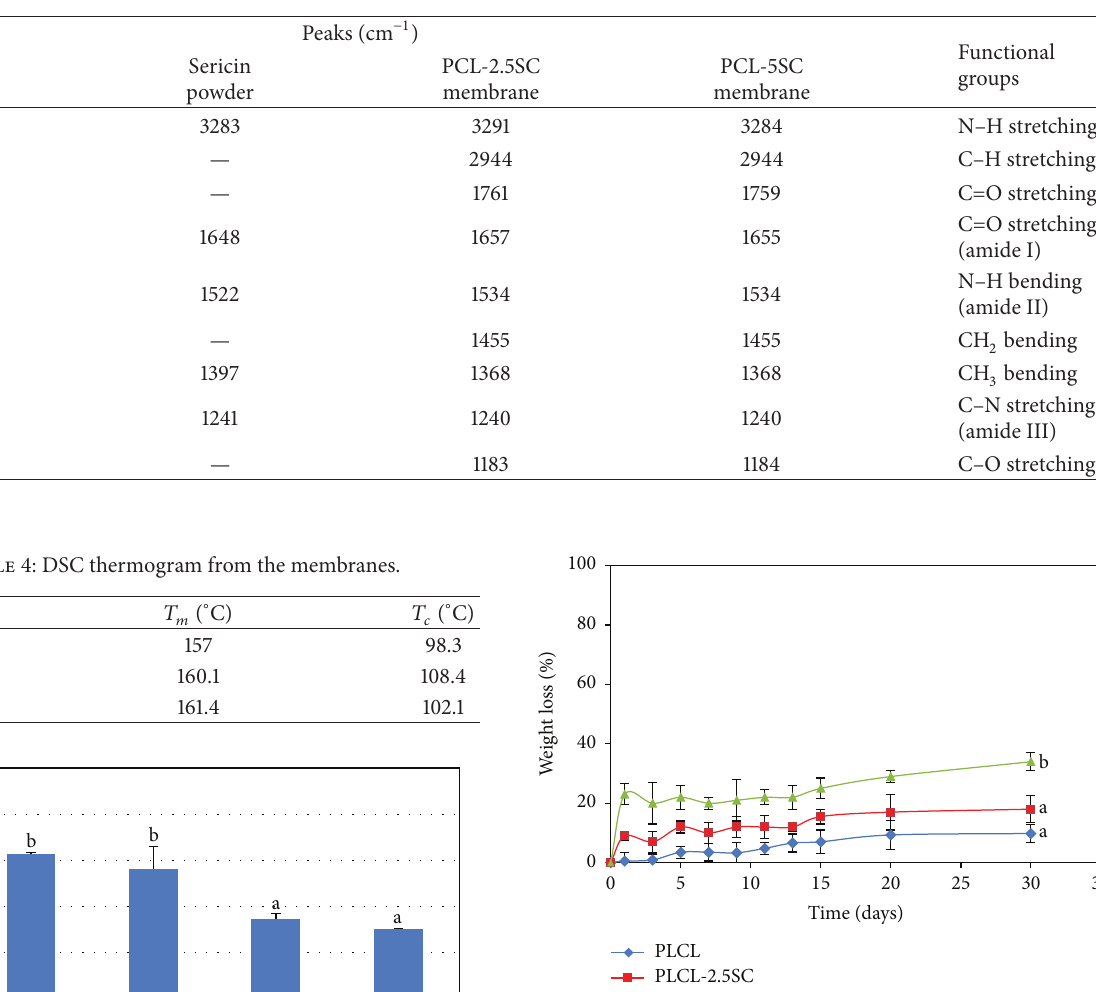
Table 3: FT-IR spectral and analyzed functional groups from the membranes.